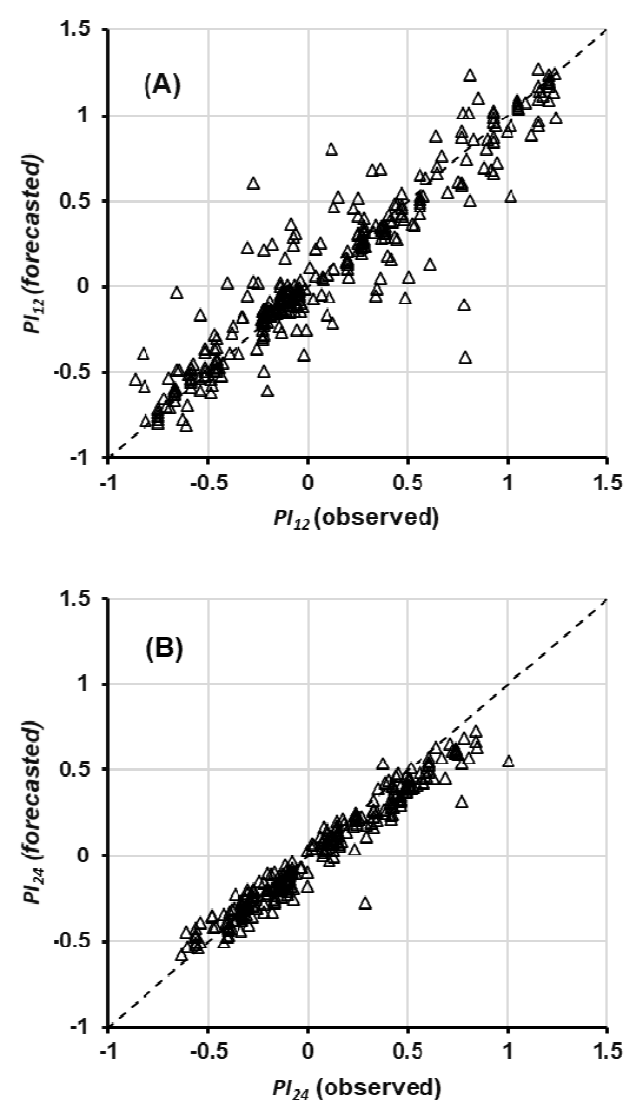
Figure 8. Forecasted vs. observed precipitation indices for the ( A ) 12-month and ( B ) 24-month scale models.